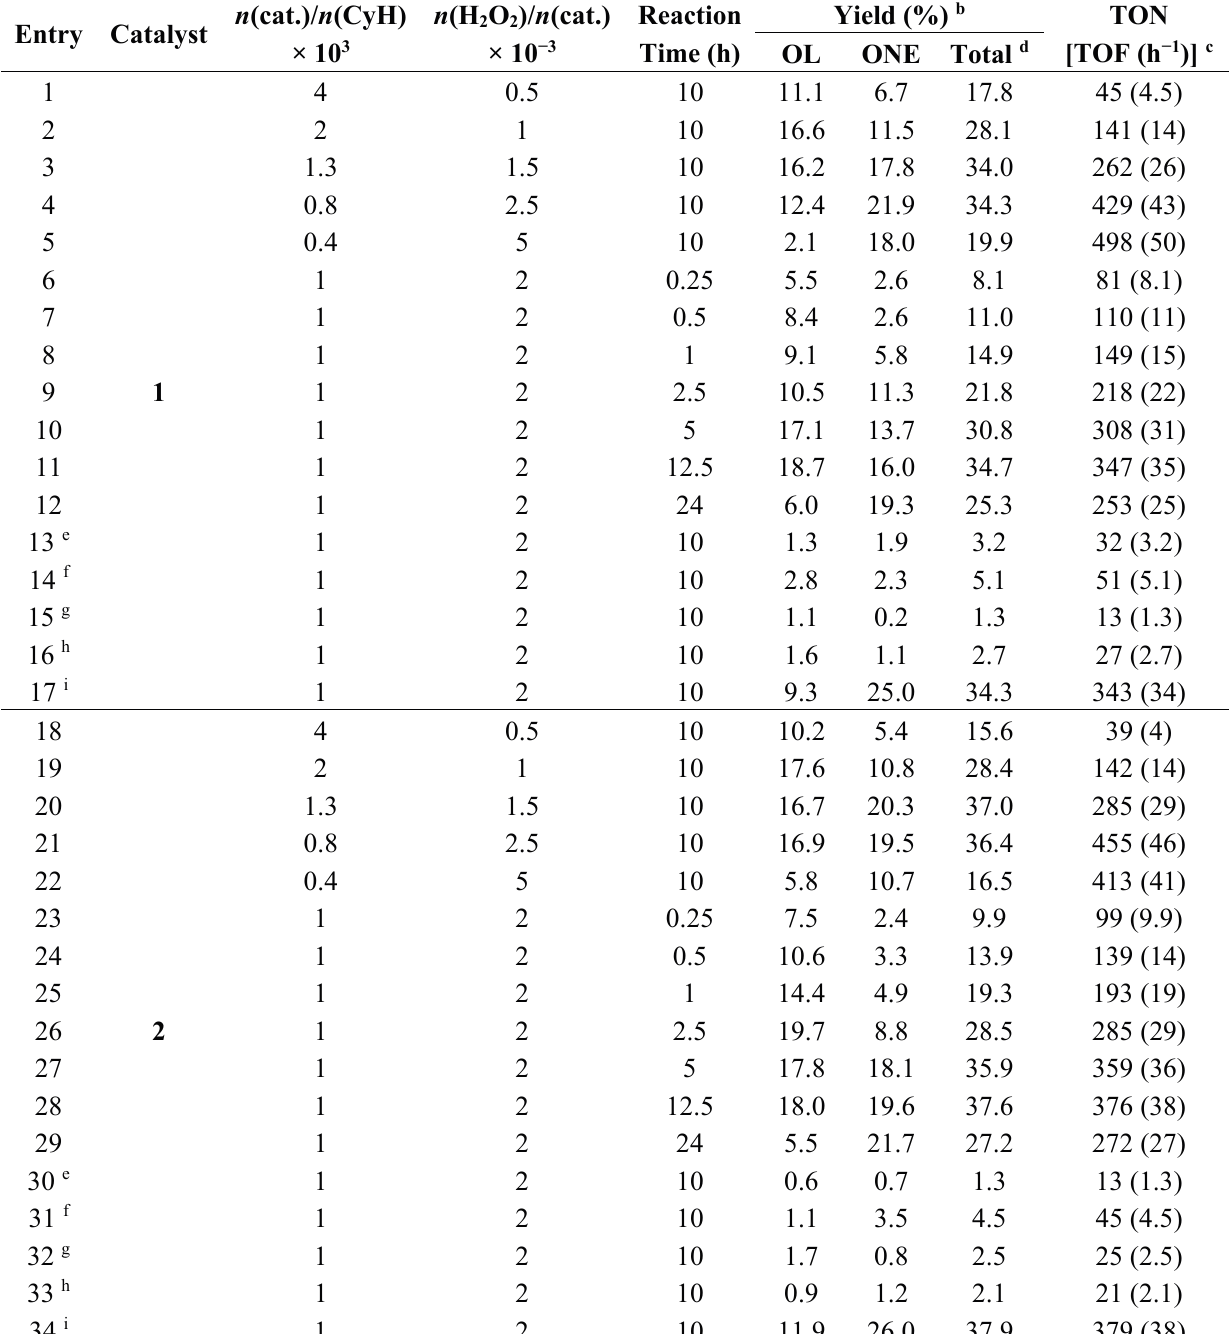
Table 2. Peroxidative oxidation of cyclohexane with H 2 O 2 (selected data) a